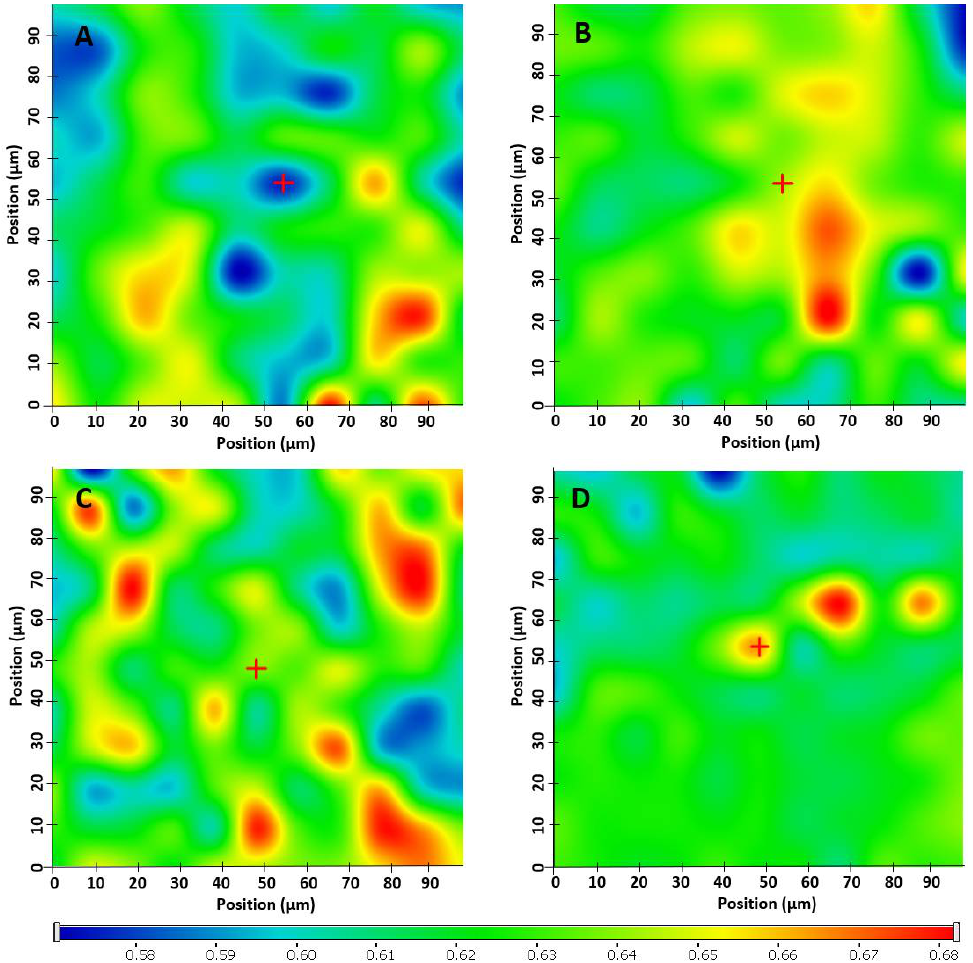
Figure 5. Raman mapping depictions of ( A ) Mow-fil, ( B ) Mow-tab, ( C ) Par-fil, ( D ) Par-tab.